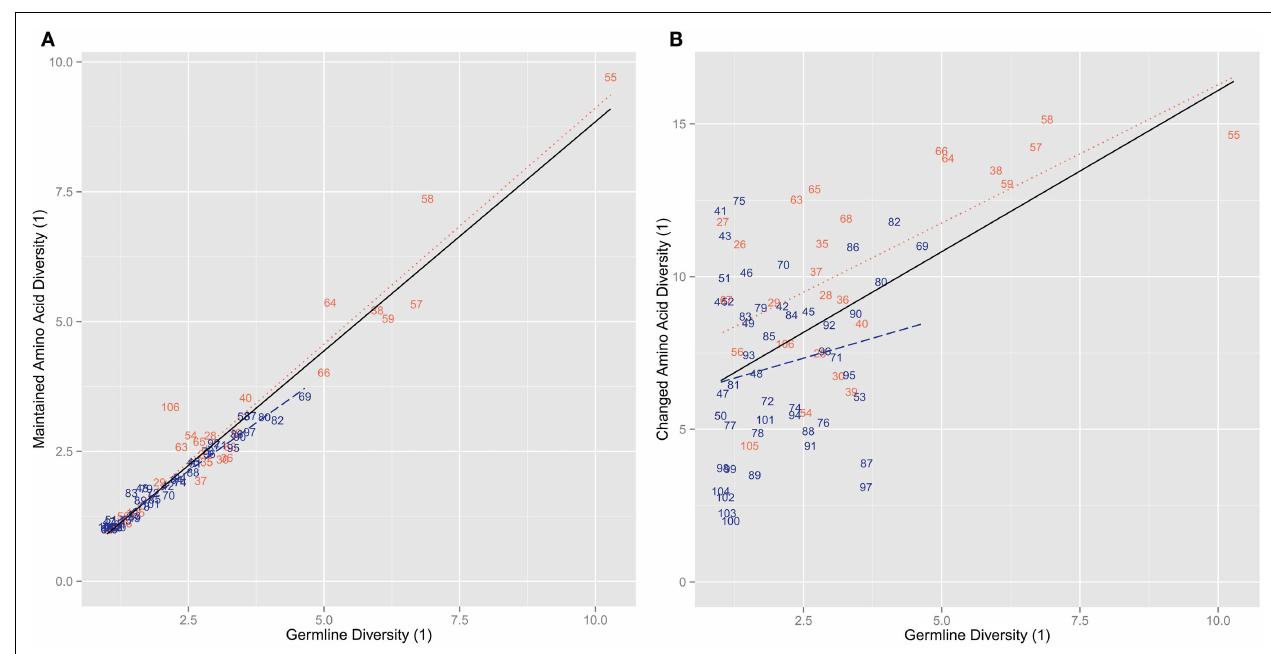
p = 1.76 × 10 − 6 ). (B) The diversity of order 1 amino acid usage of unique changed amino acids.We found a positive correlation ( r 2 = 0.284, ρ = 0.359, p = 1.70 × 10 − 3 ).When splitting the positions by regions, however, FR did not correlate with the germline diversities ( r 2 = 0.0347, ρ = 0.132, p = 0.371) while CDR did have a positive correlation ( r 2 = 0.419, ρ = 0.580, p = 2.27 × 10 − 3 ).